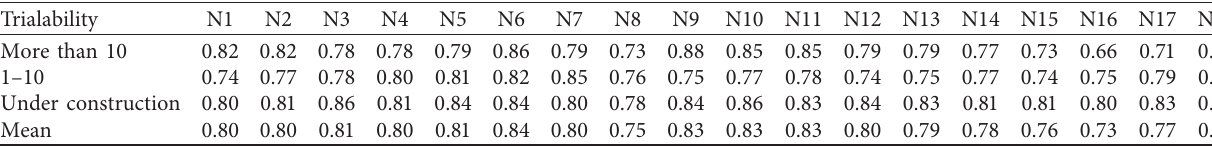
Table 9: The trialability score of each BIM application area.